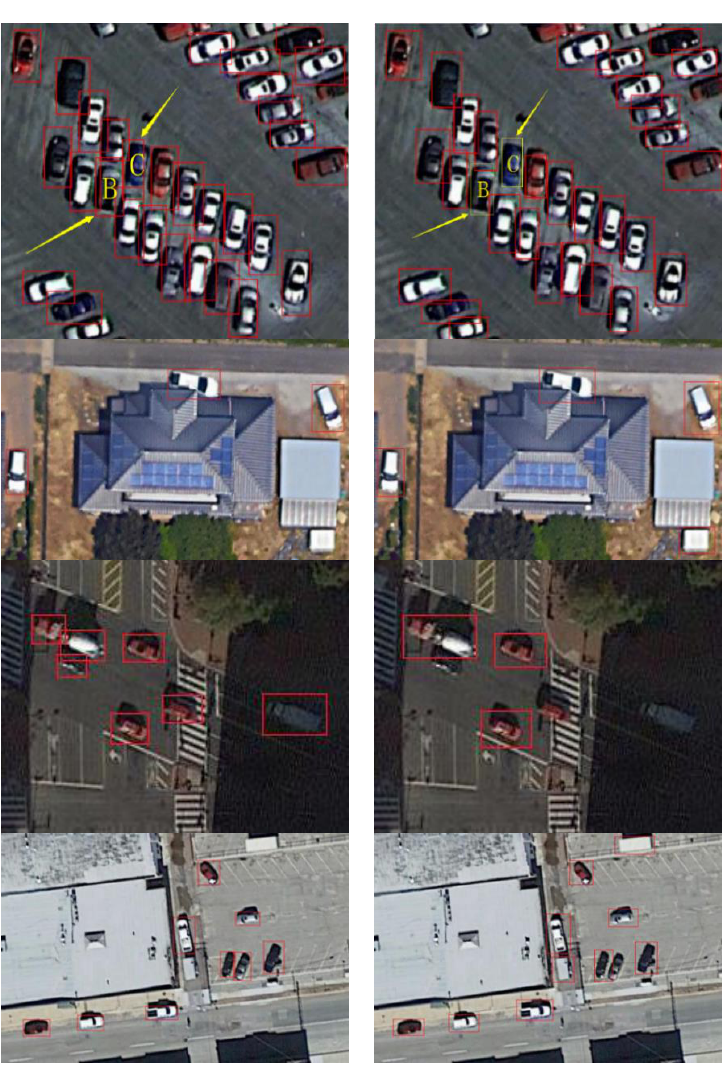
Figure 16. Comparison of Multi-PerNet 3 ( left ) and ZF-net ( right ) test results.